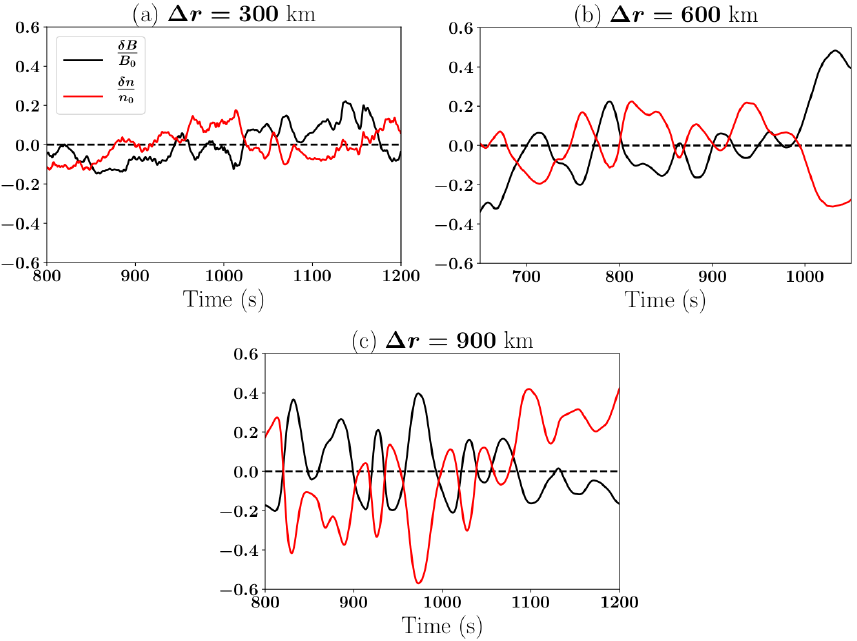
Figure 5. Magnetic field (black) and density (red) fluctuations for the three simulations measured at the virtual spacecraft locations indicated by a black and white dot in Fig. 1.